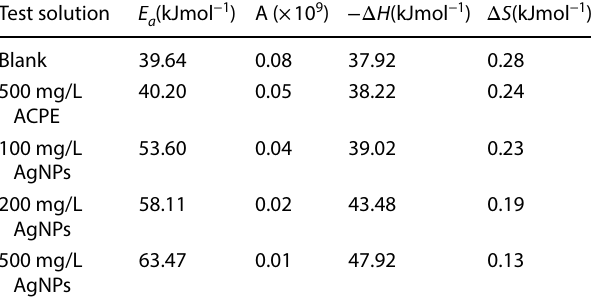
Table 6 Activation parameters for the inhibition of X80 steel corro- sion in 1 M HCl containing different concentrations of Et-AgNPs Test